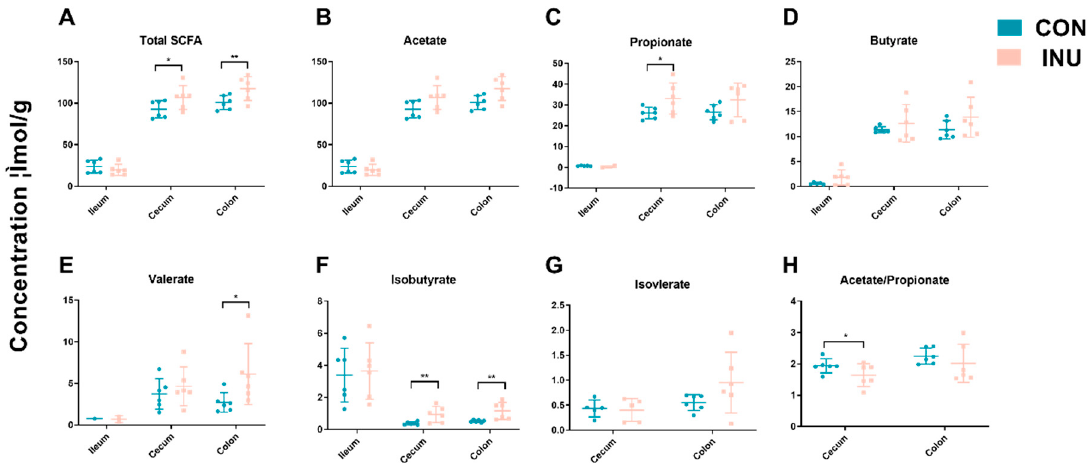
Figure 4. Short chain fatty acid (SCFA) concentrations ( μ mol/g) from ileal, cecal and colonic contents in growing pigs fed a diet with or without a 5% inulin supplement. Total SCFAs are the sum of the following SCFAs: acetate, propionate, isobutyrate, butyrate, isovalerate, valerate. Group differences were tested with Wilcoxon tests. ** p < 0.01; * p < 0.05. Con, control; Inu, inulin.